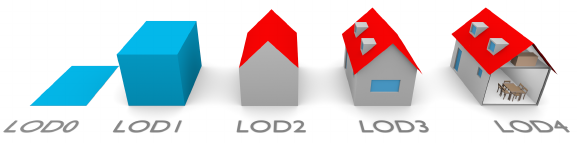
Figure 1. A building represented in LOD0 to LOD4 (image from Biljecki et al.